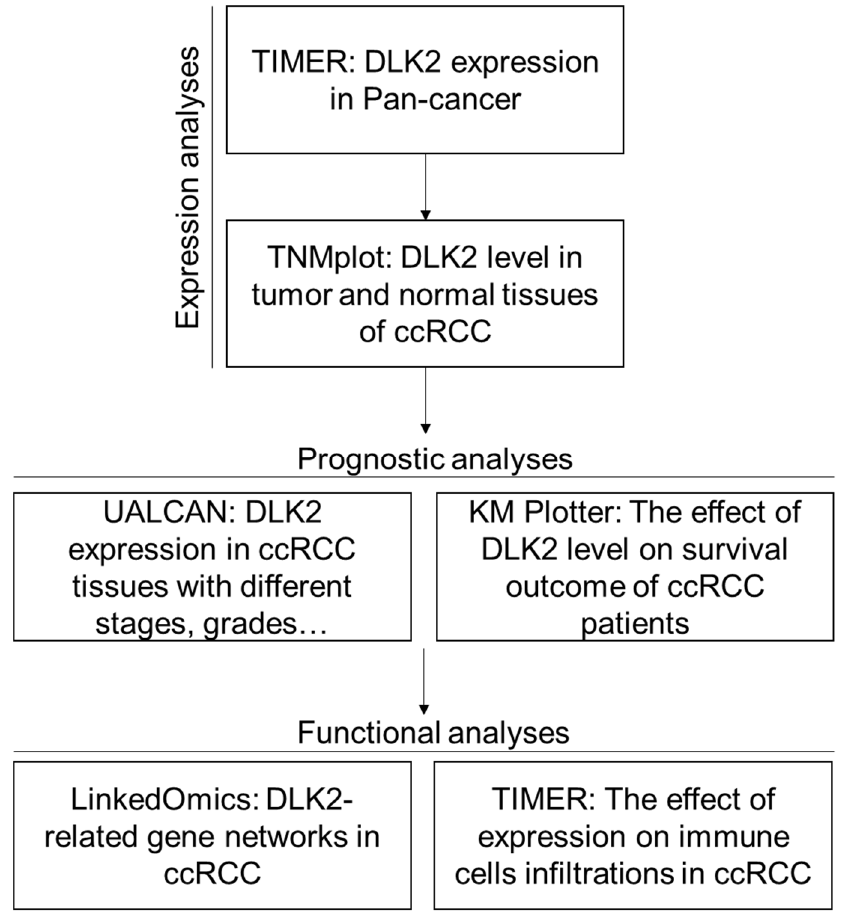
Figure 1. The study workflow indicates the expression, prognostic, and functional analyses that were used to investigate the role of DLK2 in ccRCC.